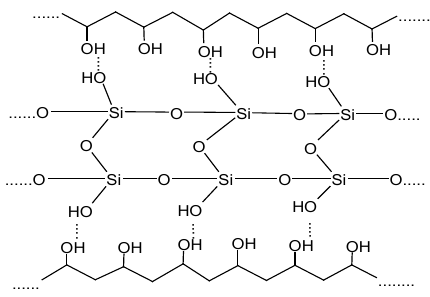
Scheme 2. PVA/TEOS matrix.